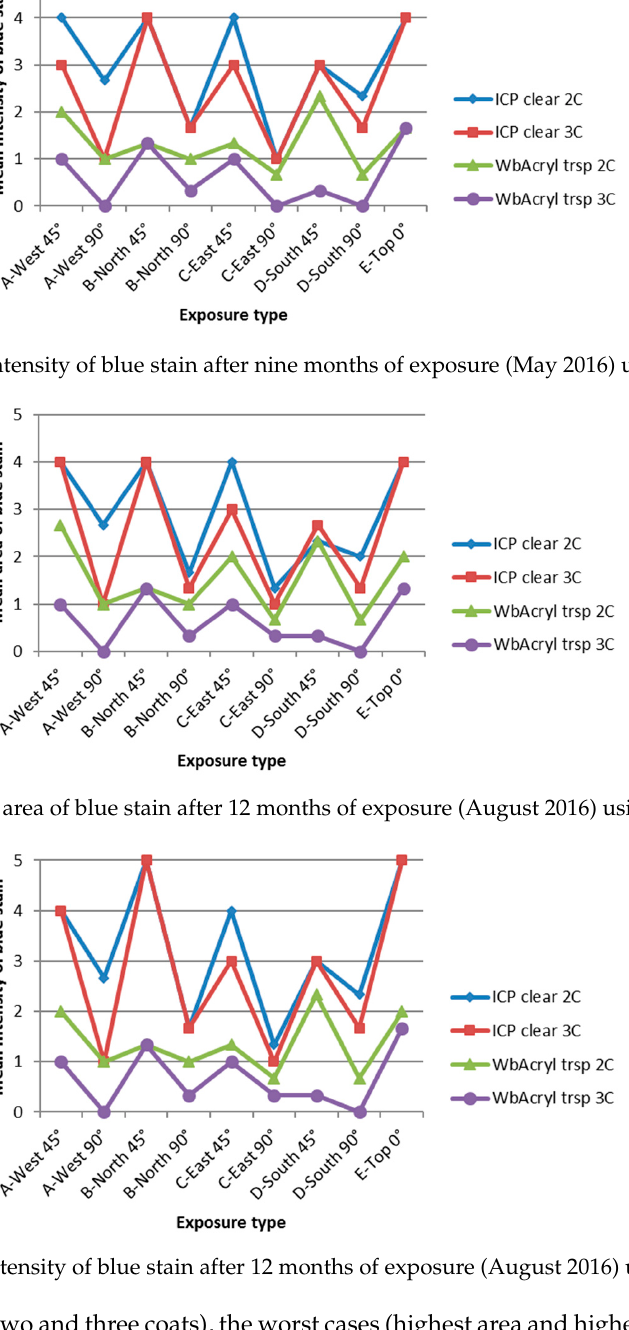
Figure 12. Mean intensity of blue stain after 12 months of exposure (August 2016) using the MFER.